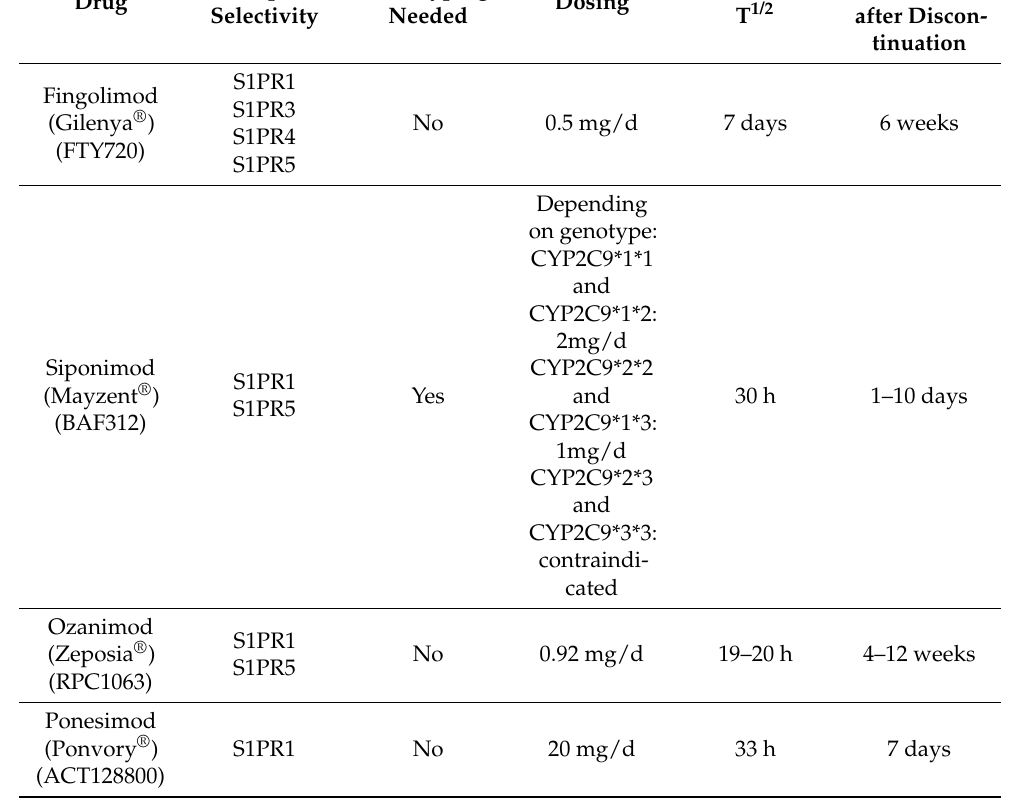
Table 1. Summary of different characteristics of the S1P modulators. Receptor Drug Selectivity